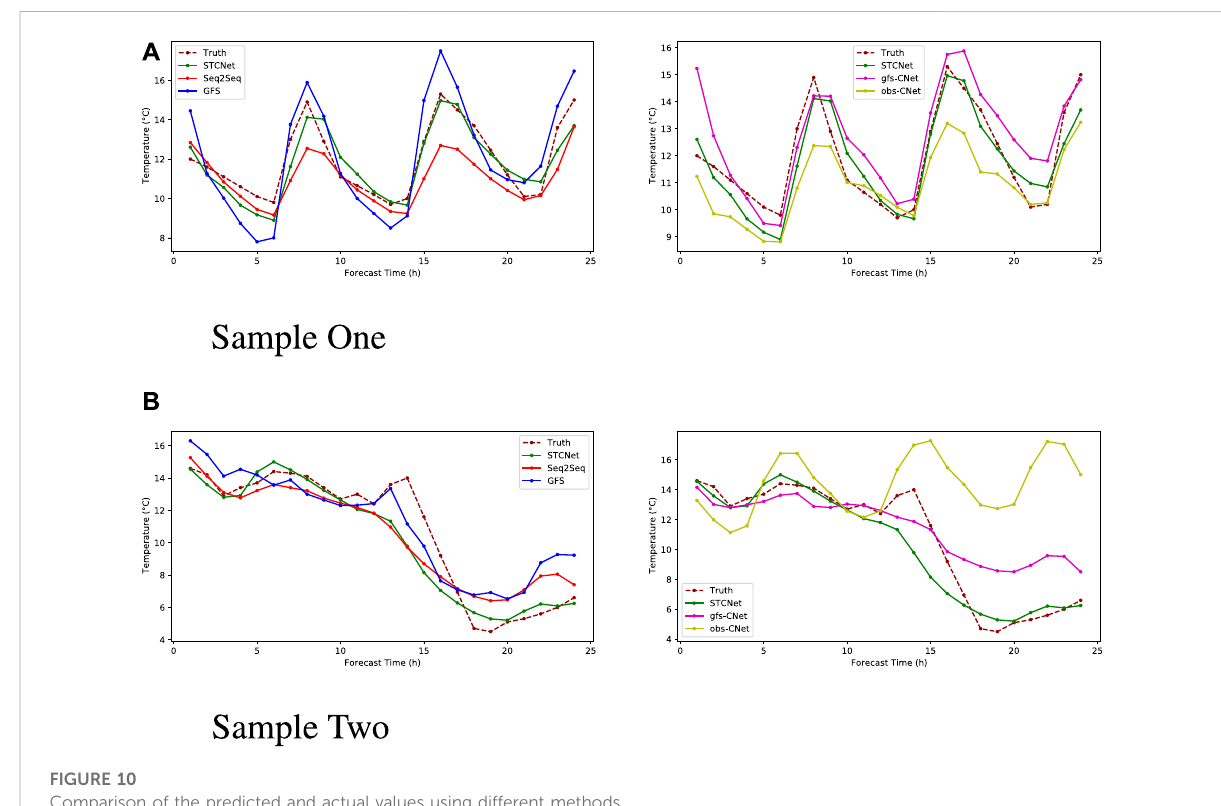
FIGURE 10 Comparison of the predicted and actual values using different